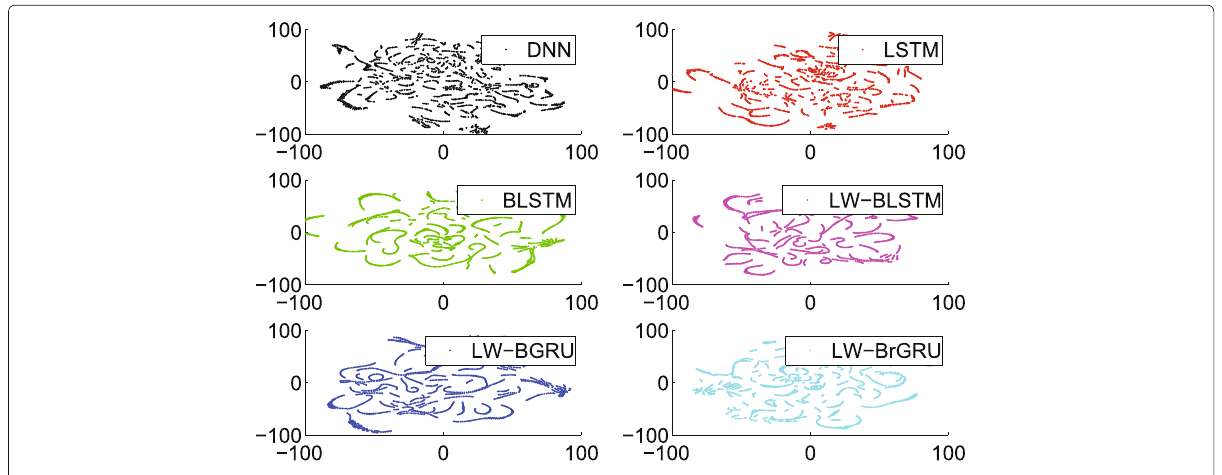
Fig. 6 The temporal trace of different acoustic